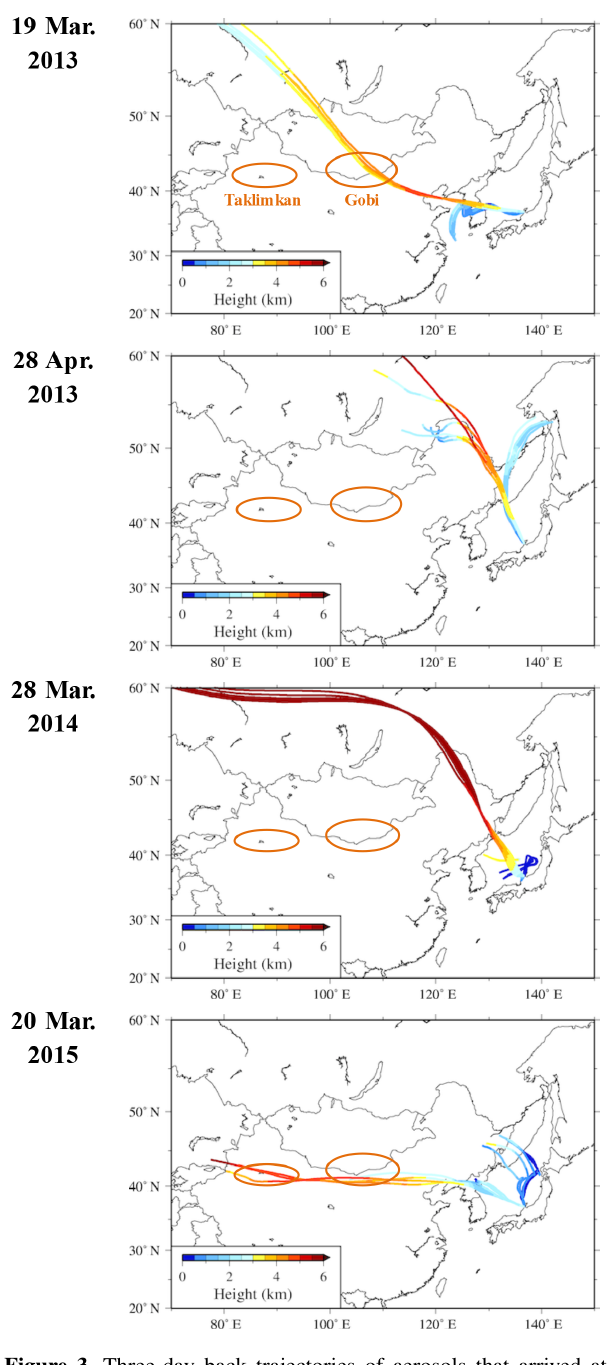
Figure 3. Three-day back trajectories of aerosols that arrived at 2500m (blue-type lines) and 1200m (red-type lines) in Hakui, Japan, every hour for 5h before the completion of sampling time on four dates: 19 March 2013, 28 April 2013, 28 March 2014, and 20 March